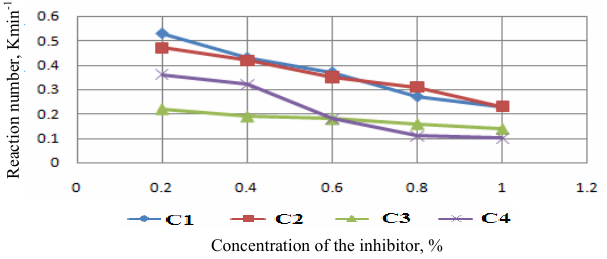
Figure 4. Inhibitor concentration (%) vs. reaction